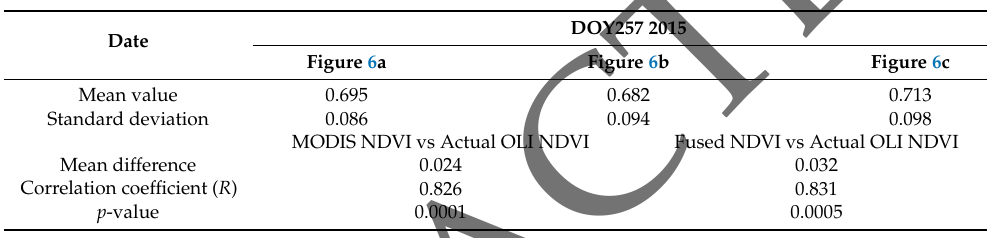
Figure 7. ( a ) Scatterplots between the actual Landsat8 NDVI and the fused NDVI images of DOY257, and ( b ) scatterplots between the actual Landsat8 NDVI and MODIS NDVI. Table 3. Accuracy of the MODIS NDVI (Figure 6a), the fused NDVI images (Figure 6b), and the actual Landsat8 NDVI (Figure